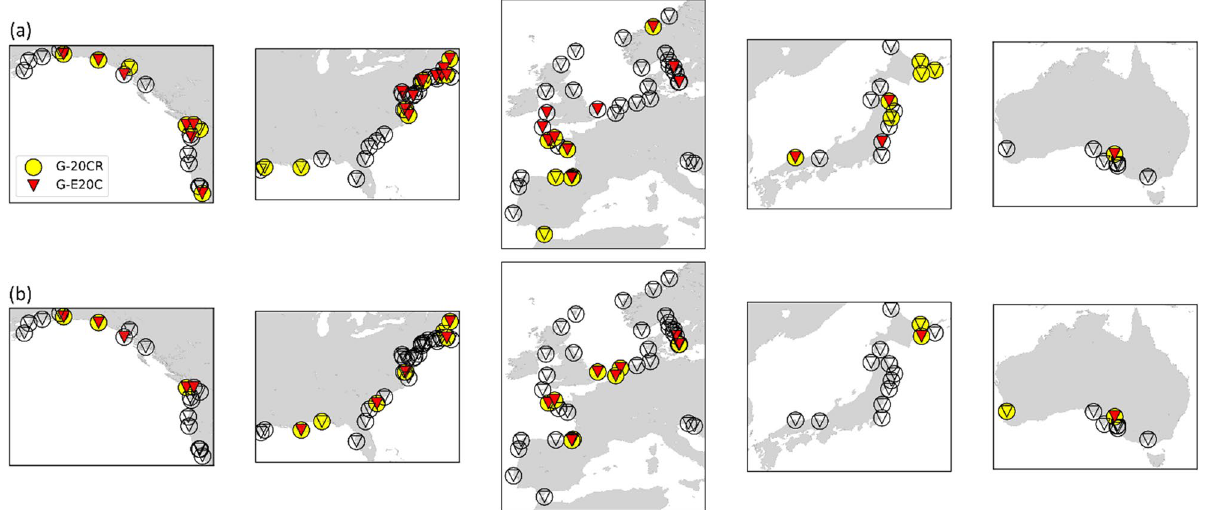
Figure 5. Tide gauges with significant differences in trends between observed surge and reconstructed surge from G-20CR (yellow circles) and G-E20C (red triangles) using the annual 95th ( a ) and 99th ( b ) percentiles. Tide gauges with insignificant differences in trends are shown as transparent circles and triangles. Trends are computed when at least 30 years of overlapping data are available for the 1930–2010 period. Rossum, Guido van, et al., The Python Language Reference, Python Software Foundation; http:// docs. python. org/ py3k/ refer ence/ index. html.